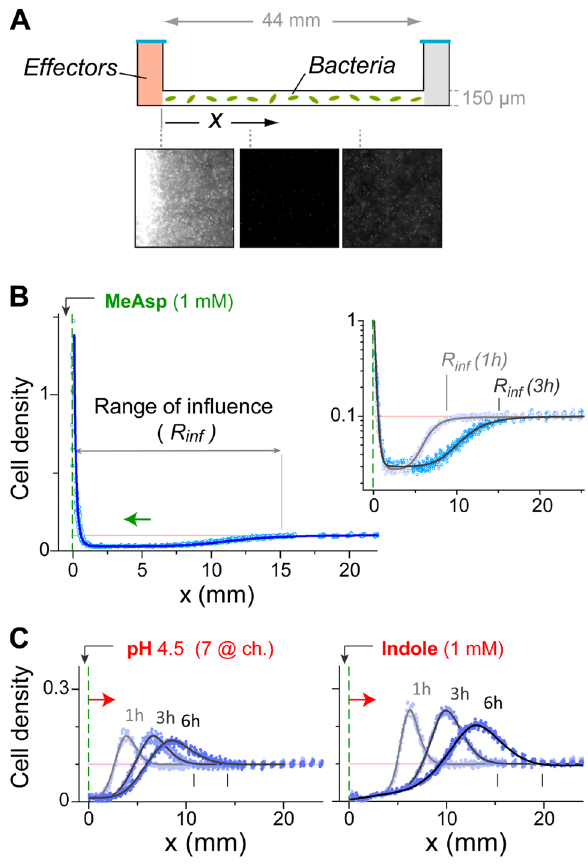
Figure 1. Bacterial responses to either attractant or repellent effectors at the source. ( A ) General description of the experimental setup (see also Fig. S1). A long channel was used with an effective ‘source’ on one side (left) containing the effectors. The distribution of the GFP-expressing bacteria was followed by fluorescence imaging. A few examples are also shown for an experiment with a MeAsp source. ( B ) The bacterial distribution along the channel 3 h after the addition of MeAsp (1 mM) to the source. Inset —the bacterial distribution at 1 and 3 h shown on a semilog scale. The ‘range of influence’ R inf is defined as the distance from the source where the bacterial density approaches the initial (unperturbed) value. ( C ) The bacterial distribution along the channel at different times after the introduction of either low pH (4.5) or indole (1 mM) to the source. Throughout, cell density is normalized to the cell density at OD 600 1, and the initial uniform bacterial density (0.1) is marked by the light pink